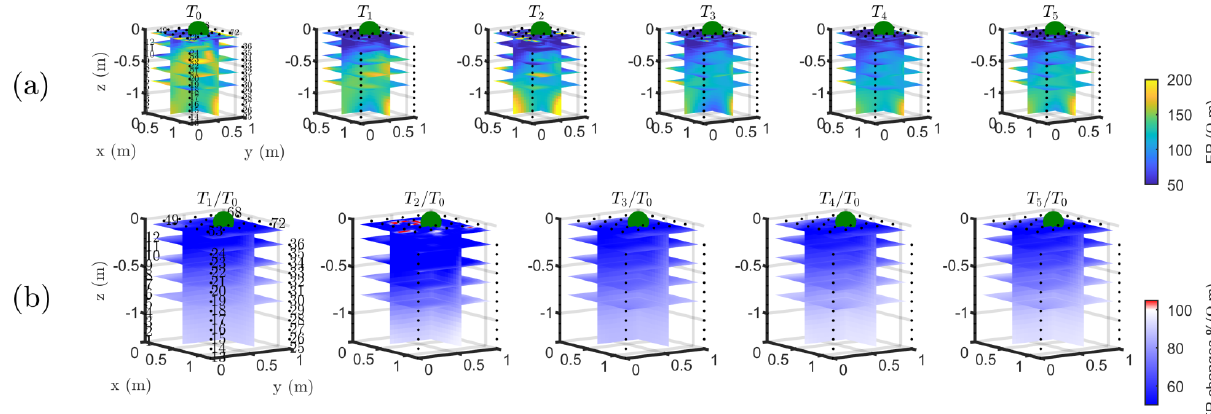
Figure B1. Three-dimensional ERT results for plant A. The volume is sliced at the tree stem position (vertically) and at five depths (0.05, 0.2, 0,4, 0.6 and 0.8m). (a) Three-dimensional inversion of the resistivity (in (cid:127) m, log scale) from the background time T 0 , during irrigation T 1 and after irrigation. (b) Time-lapse inversion (following Cassiani et al., 2006) showing the ratios (in % of ER changes) between time step T i and background time T 0 (100% in white means no